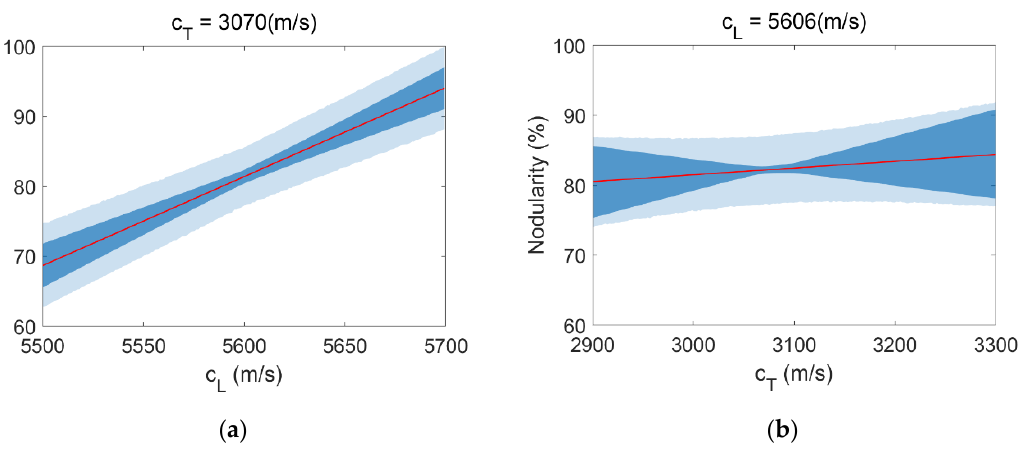
Figure 5. (Color Online) The regression function and its associated 90% confidence bounds of traditional Bayesian regression model from the first week only. ( a ) A cross-section at c T = 3070 m/s, and ( b ) a cross-section at c L = 5606 m/s.